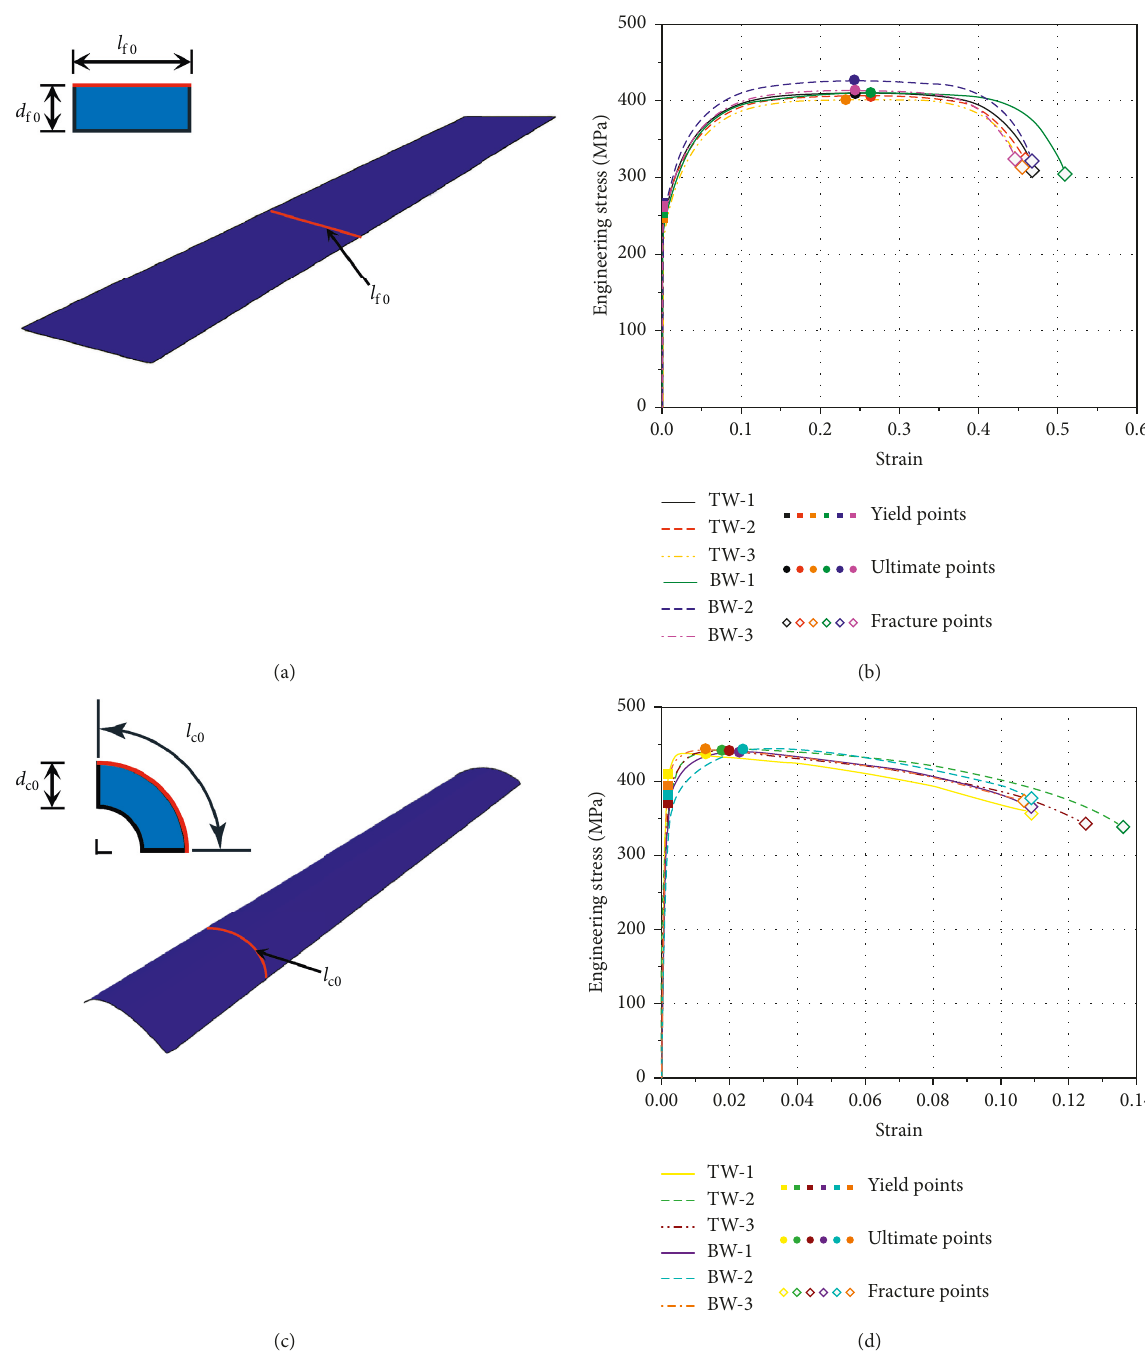
Figure 8: Measurement of engineering stress-strain curves: (a) diagram of initial section area measurement of flat coupon; (b) engineering stress-strain curves of flat coupons; (c) diagram of initial section area measurement of corner coupon; (d) engineering stress-strain curves of corner